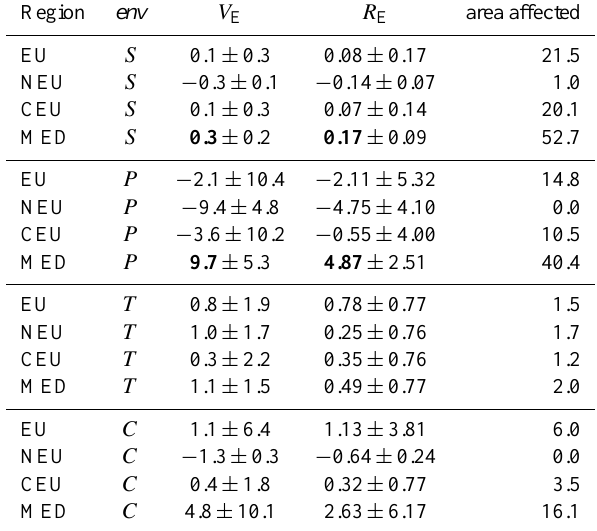
Table A1. Ecosystem vulnerability V E and risk R E (mean value ± standard deviation) and percentage of affected area (%) in the SREX regions (Table 1) of yearly carbon loss (NBP < 0) to the env variables SPEI S ( − ), precipitation P (mmmonth − 1 ), temperature T (K), and consecutive dry days C (daysmonth − 1 ) for significant cells. Bold numbers denote high positive values (mean value > stan- dard